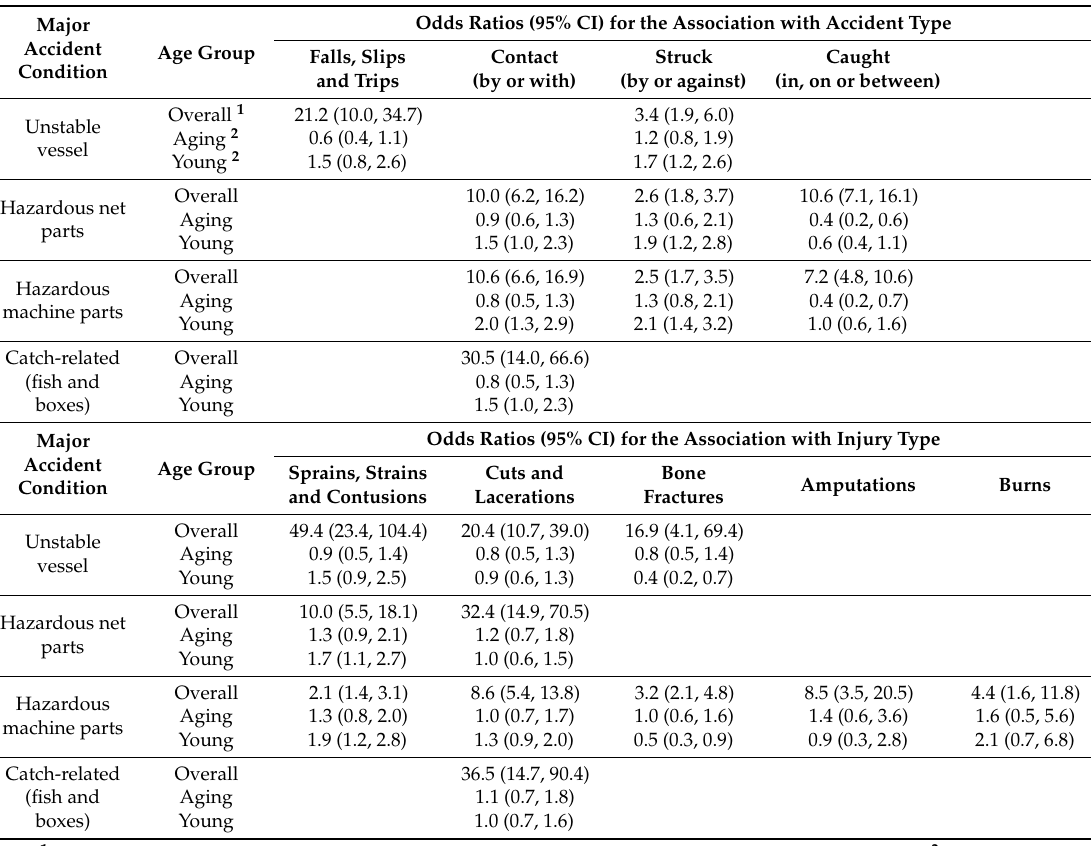
Table 3. Logistic regression analysis of the association of both age group and major accident conditions (as predictors) with accident types and injury types (as responses) (only important associations are displayed for table simplicity and